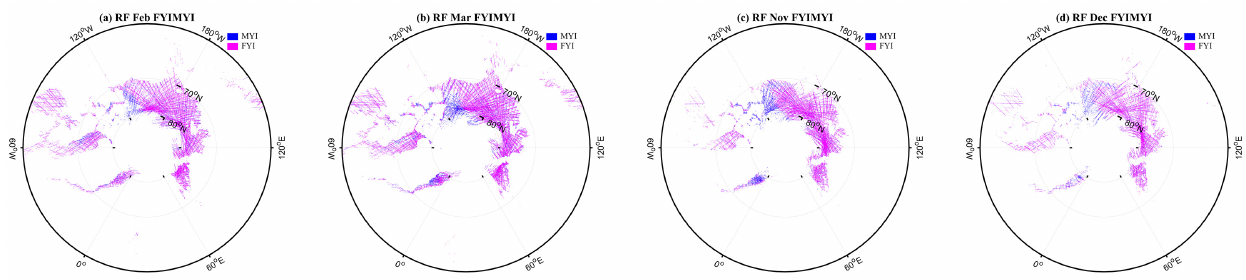
Figure A12. RF for FYI-MYI classification using the data in March as the training set. The data in ( a ) February, ( b ) April, ( c ) November, and ( d ) December are used as the test set in turn.